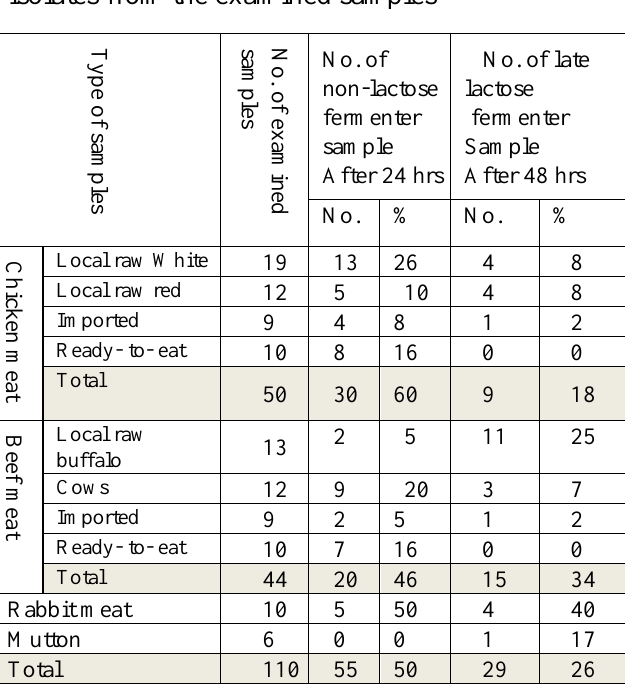
* The percentage was calculated according to the total number of positive samples.